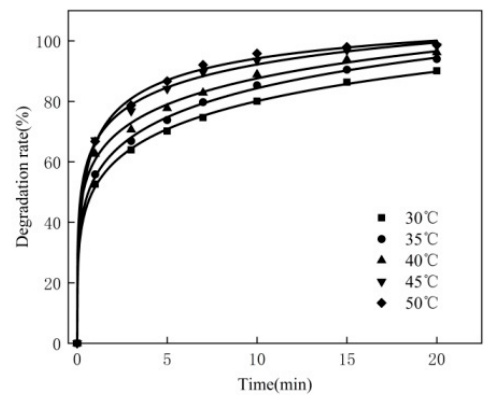
Figure 2. Effect of reaction temperature.